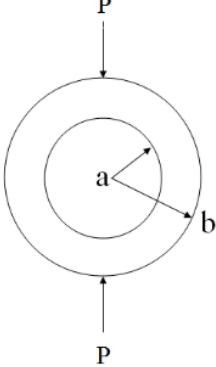
Table 5. Constitutive parameters for matrix.